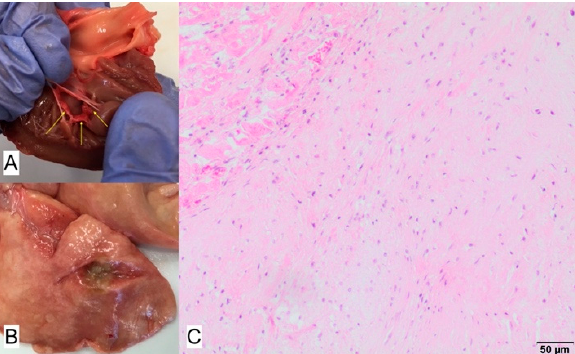
Figure 11. ( A ) Macroscopic view: yellow arrows point to the thickened mitral valve. ( B ) Macroscopic view: large number of purulent lesions in the lungs ( C ). Microscopic view of base of the valve presenting increased amount of fibrous extracellular matrix; hematoxylin-eosin, magnification 40×.